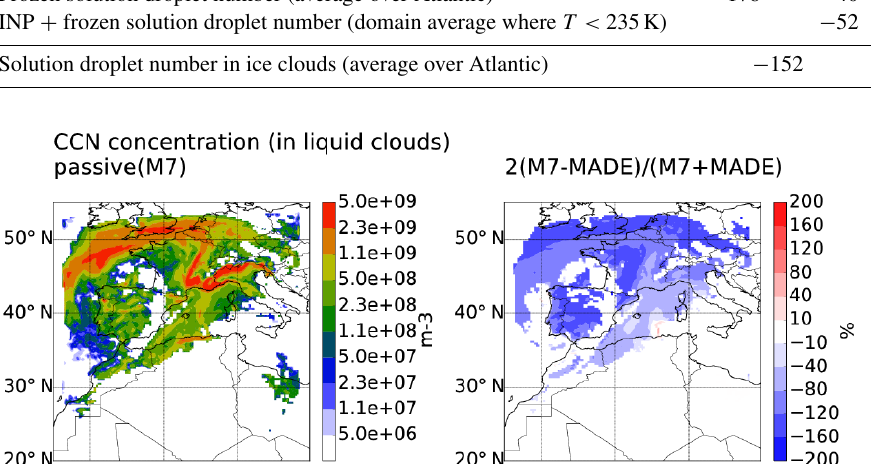
Figure 10. Liquid-cloud CCN concentrations derived from aerosol compositions predicted by M7 (left) and MADE (percentage-difference plot on the right) for Passive simulations. Contours show vertical averages of concentrations in grid boxes that contain liquid-phase but no ice-phase cloud